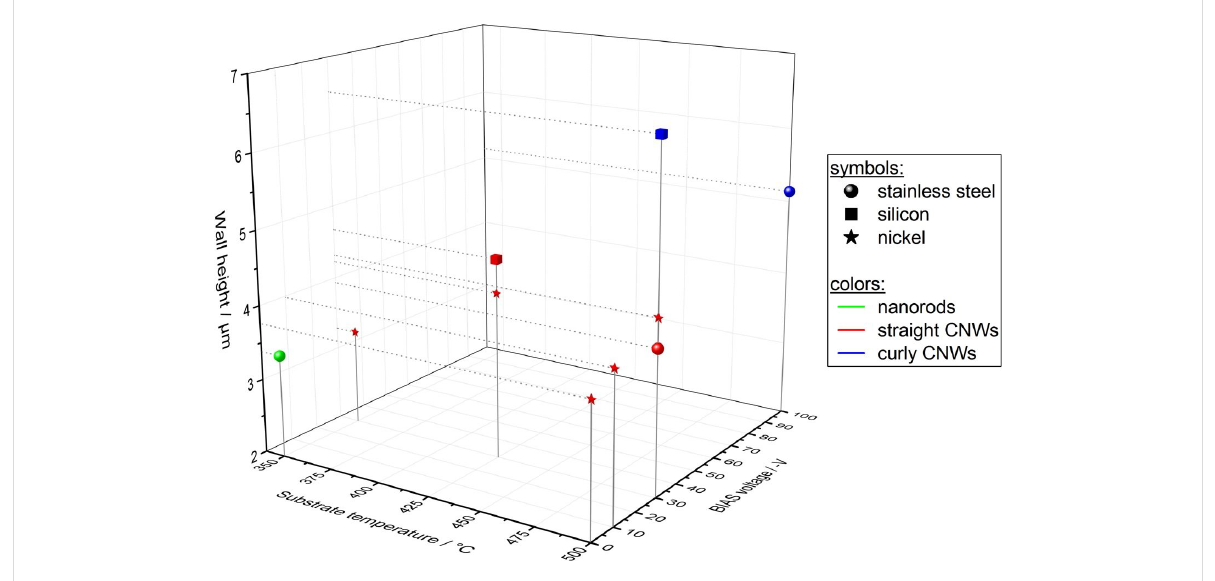
Figure 9: Heights of CNWs as a function of process parameters and substrate material.